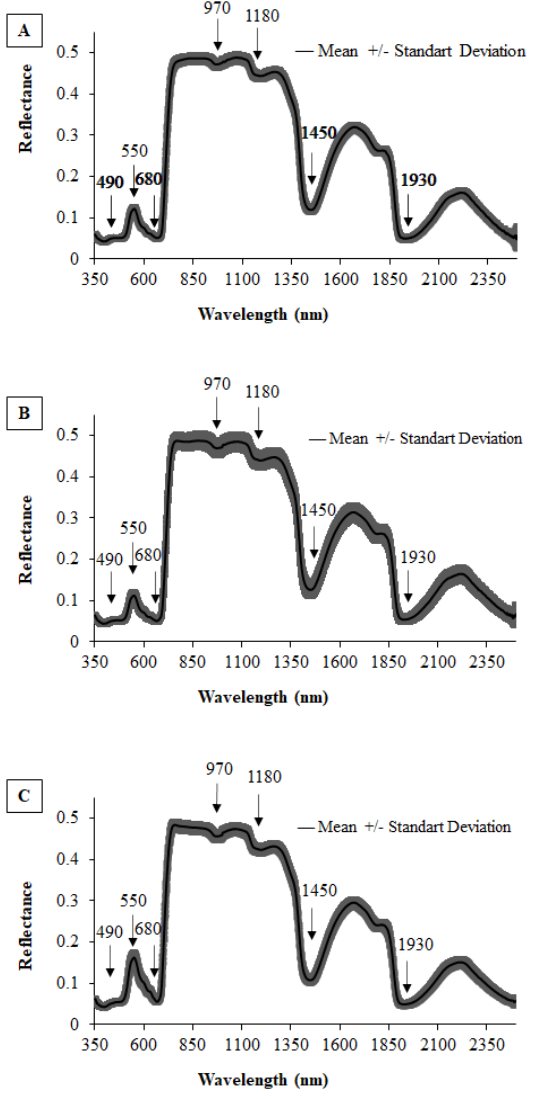
Figure 5. Mean reflectance spectra and respective standard deviations for each phenological stage: ( A ) V4, ( B ) R6 and ( C ) R9.